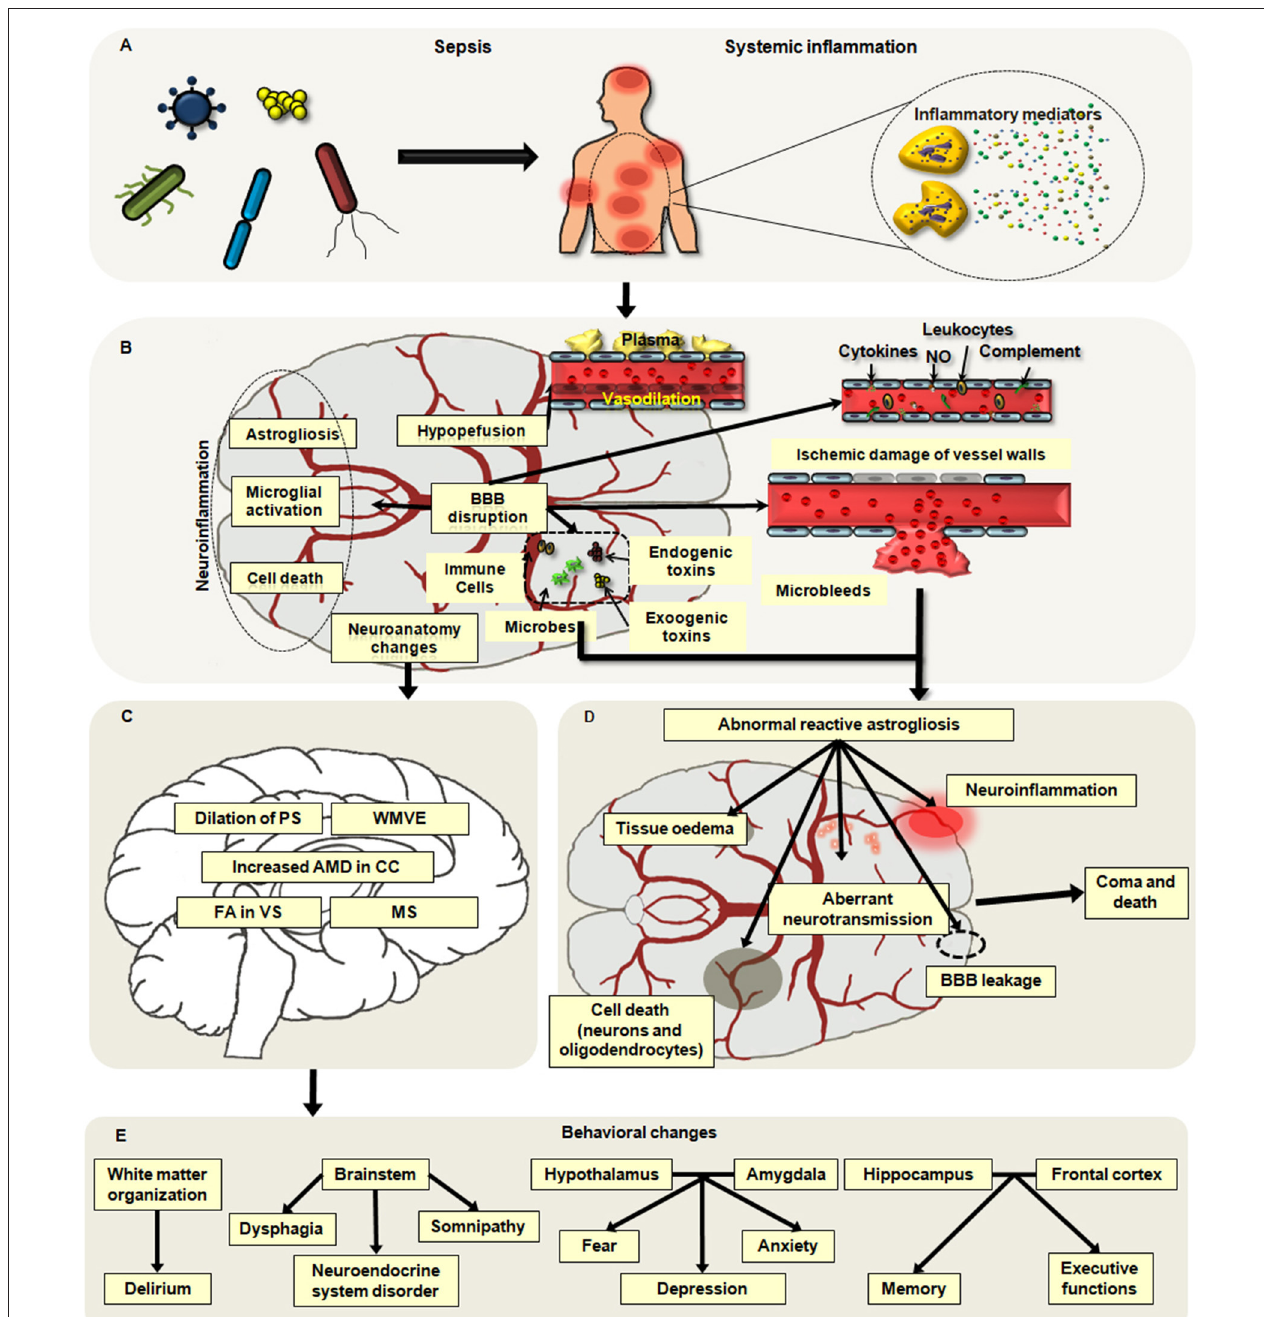
FIGURE 1 | Main pathophysiological alterations in sepsis-associated encephalopathy (SAE). (A,B) Neuroinflammation, hypoperfusion, neuroanatomy changes, and neuronal death are major causes of SAE. Neuroinflammation mainly includes the infiltration of neutrophils and the activation of microglia and astrocytes, which may aggravate brain excitotoxicity and blood–brain barrier (BBB) disruption. Hypoperfusion is frequently observed in patients with SAE, and it can be induced by abnormal vasodilation, impaired autoregulation of the cerebral blood flow (CBF), and inflammatory insults. Apoptosis and pyroptosis are common ways of neuronal cell death associated with brain dysfunction in sepsis. (C) The changes in neuroanatomy including the white matter vasogenic edema (WMVE), myelin separation (MS), dilation of the perivascular spaces (PC), increased axial water diffusion (AWD) in the corpus callosum (CC), and fractional anisotropy (FA) in the ventral striatum (VS) are noticed in patients with SAE. (D) The abnormal astroglial reactivity is regarded as a key contributor to the development of SEA. In the setting of sepsis, the BBB is disrupted by severe systemic inflammation, which may result in ischemic damage of vessel walls, microabscess formation, and infiltration of microbes, immune cells, and toxins into the brain parenchyma. These alterations can cause the abnormal reactivation of astrocytes, which will deteriorate brain injuries including BBB breakdown, neuroinflammation, tissue edema, cell death, and aberrant neuro-transmission. (E) Disorder in various regions of the brain may lead to different behavior alterations secondary to septic